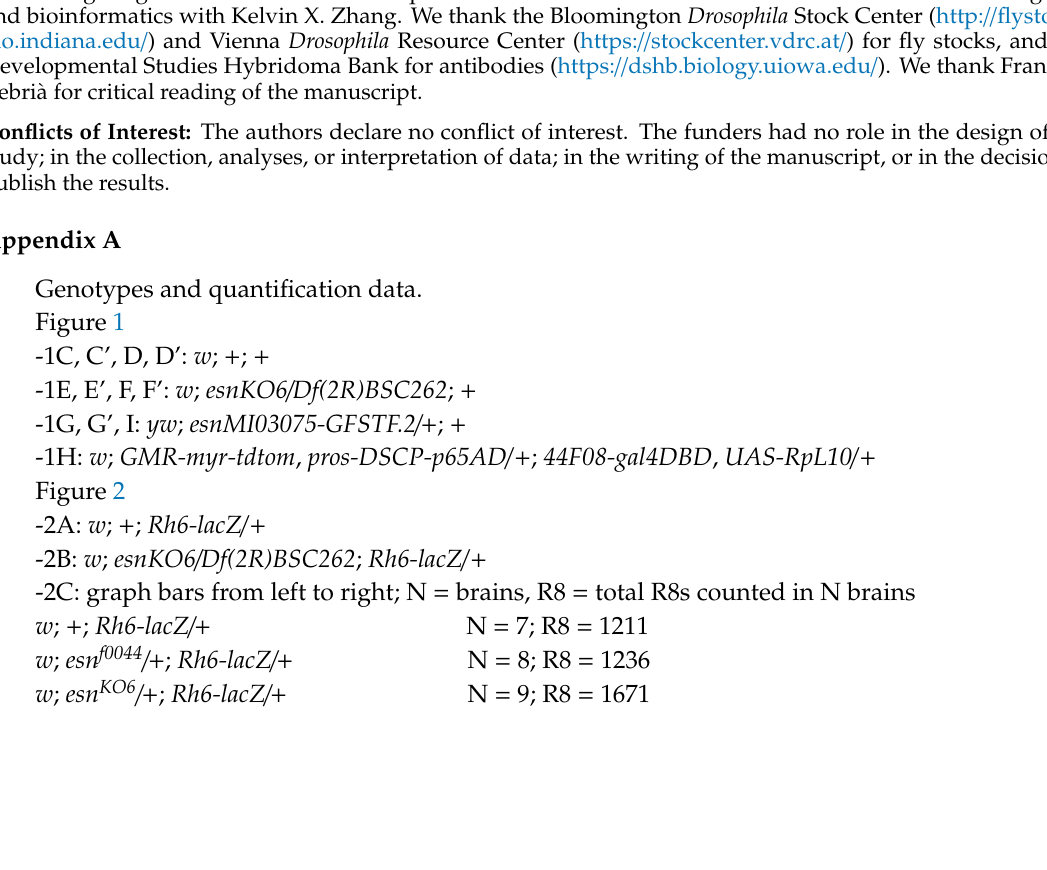
Figure S1: Extended Espinas (Esn) expression analysis, Figure S2: Analysis of prickle ( pk ) mutant